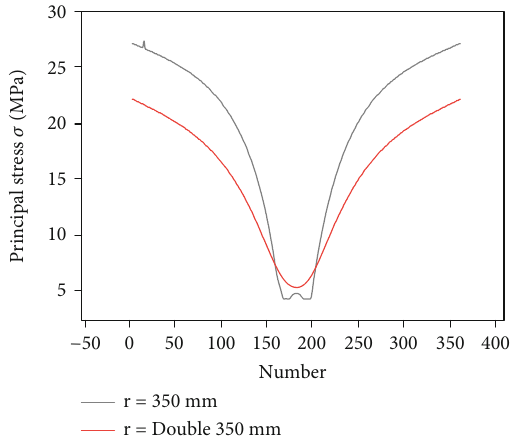
Figure 19: Distribution of principal stress in 350-mm single and double holes.